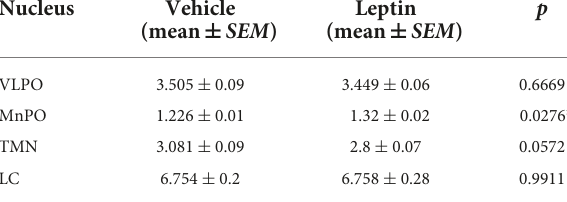
TABLE 2 Optical density of GAD65 expression in leptin